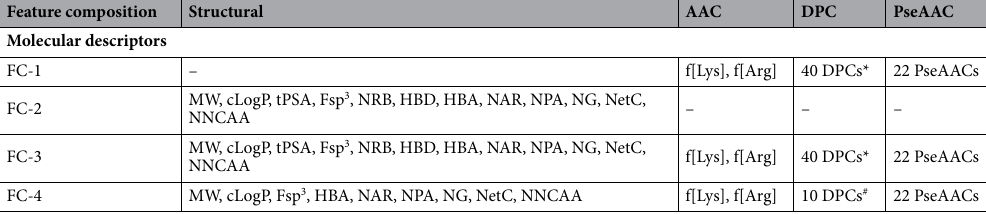
Table 4. Distribution of structure-, and sequence-based descriptors in four feature compositions used in BChemRF-CPPred. *The 40 DPCs descriptors previously cited in this session. # The 10 DPCs descriptors: RR,